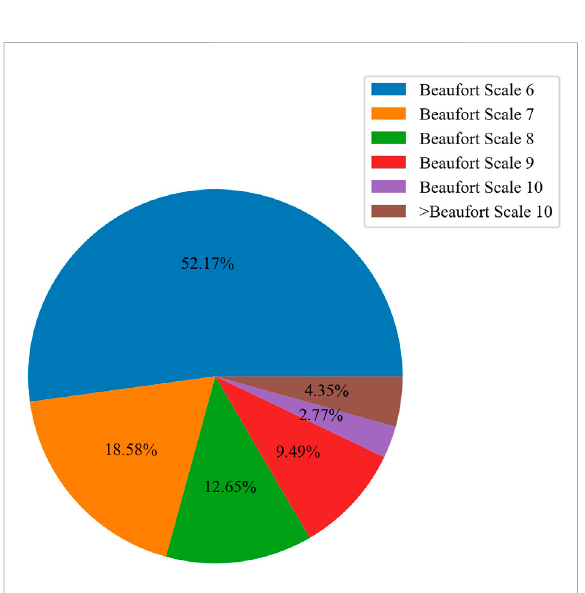
FIGURE 5 Proportions of different wind speed magnitudes of the TC- induced gales in 16 training samples.